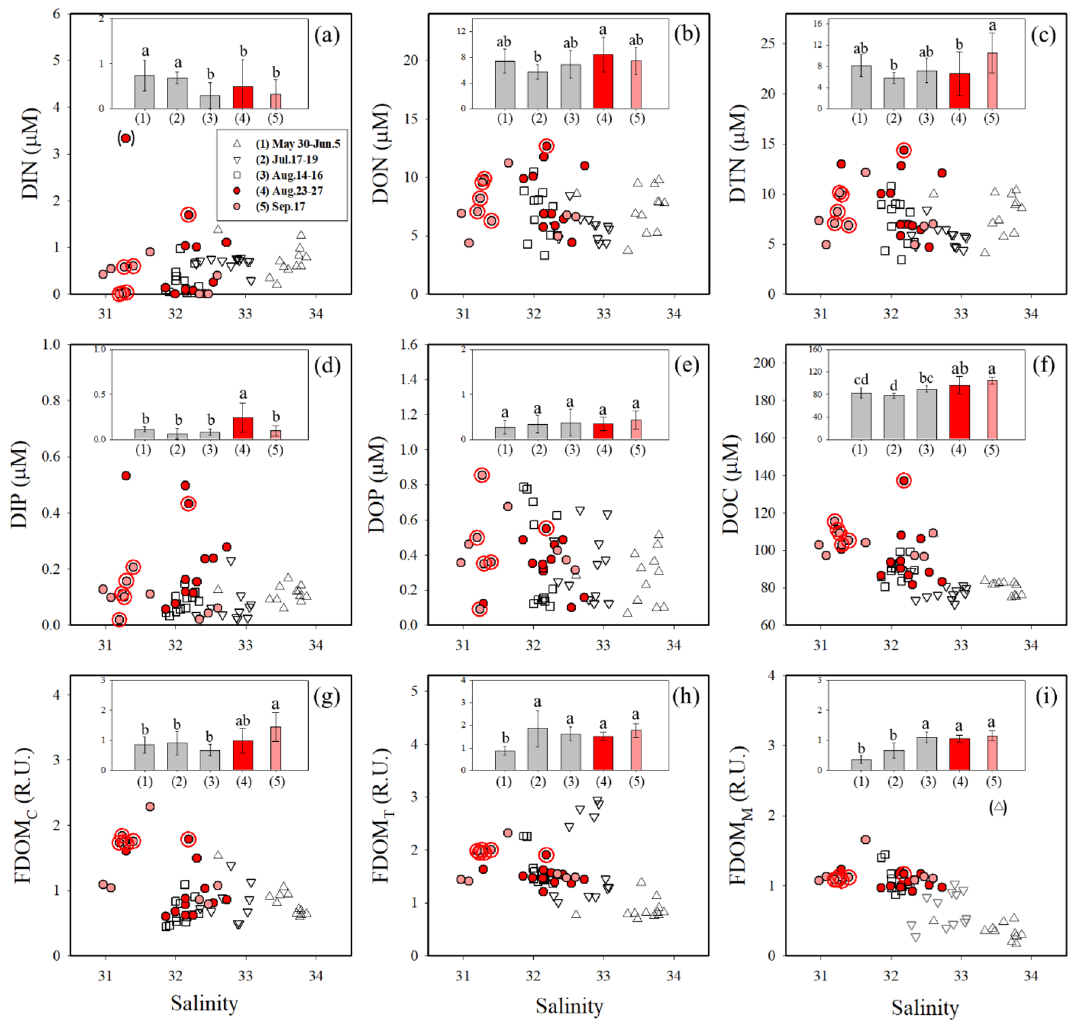
Figure 3. Scatter plots of salinities versus ( a ) DIN, ( b ) DON, ( c ) DTN, ( d ) DIP, ( e ) DOP, ( f ) DOC, ( g ) FDOM C , ( h ) FDOM T , and ( i ) FDOM M in the Tongyeong coast during May 30–June 5, July 17–19, August 14–16, August 23–27, and September 17, 2019. The red circles represent the centers of the red tide patches. The vertical bars in the scatter plots show the average concentrations for each period. Significance ( p ) of the differences among the group (1, 2, 3, 4, and 5) in all figures was always <